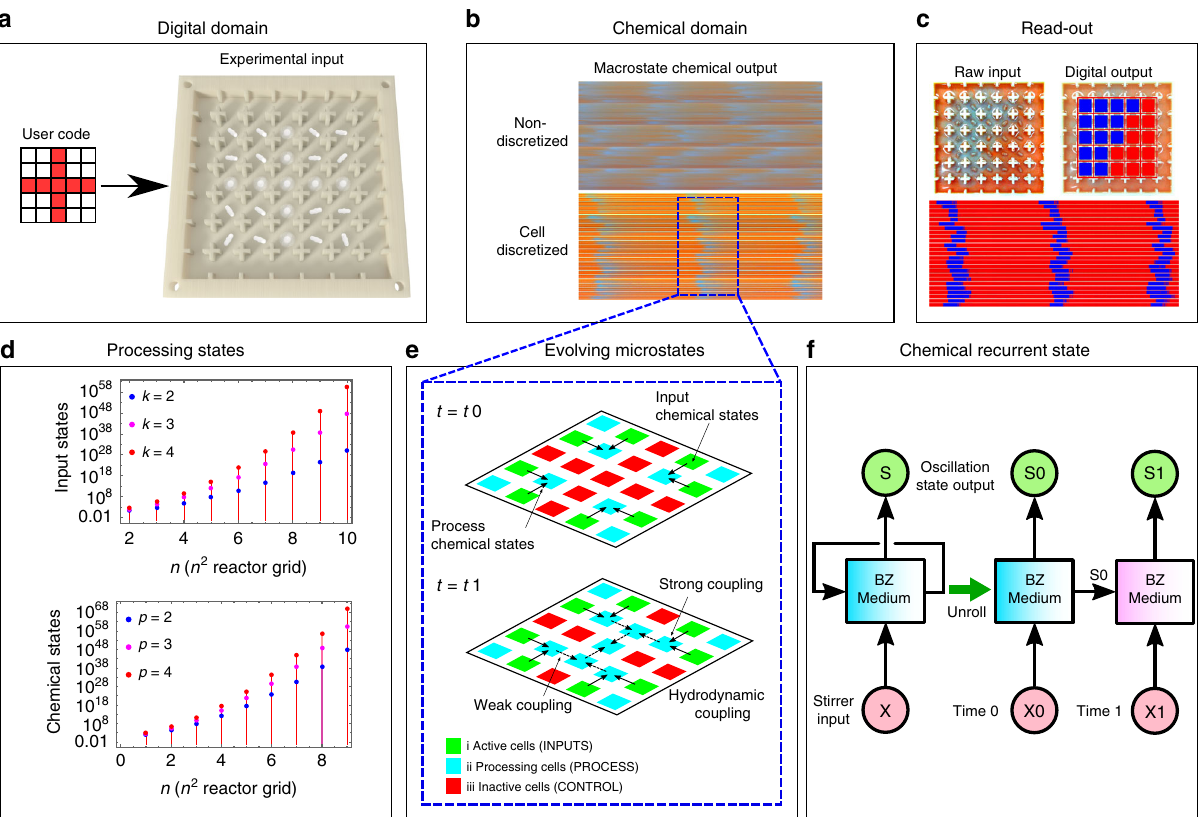
Fig. 1 Chemical processor paradigm. a Digital domain: The user inputs the actions to perform via a 5-by-5 matrix. This digital matrix is read by a computer and translated into machine code to mechanically actuate the stirrers at the user-de fi ned speed. b Chemical domain: Based on the speed at which the stirrers rotate, the BZ reaction will oscillate between its two states, and oscillating waves will appear in the platform. If the arena does not contain physical boundaries between the cells, the oscillations will not localize and they would spread. If there are physical boundaries between the cells, the oscillations will localize at the speci fi c cells within the arena. c Read-out: Using a camera and image processing, the states of the chemical processor are read by a digital computer. For every cell, the image processing algorithm will classify its state as on or off, depending on if the BZ reaction is oscillating on it. This step will return a 5-by-5 digital matrix representing the state of the system at each cell. d The Input States plot shows the scaling of the number of input states with the number of BZ cells on the experimental platform at different PWM stirring inputs ( k nxn , where k can be 2, 3 and 4). The Chemical States plot shows scaling of the number of chemical states (de fi ned by the distinct measurable amplitudes of BZ oscillations; see Supplementary Information) with the number of BZ cells on the experimental platform at a different number of measurable oscillation amplitudes (( p + 1) nxn where p describes the different detectable oscillation amplitudes and an additional one for no oscillation). e Evolving microstates: The cells in the arena are weakly connected; therefore, their oscillations will convolve, and be able to perform complex calculations by controlling the stirring speeds into (i) active cells — fast stirring — for inputs, (ii) process cells — slow stirring, (iii) inactive cells — no stirring (see Supplementary Information). f Chemical recurrent state: Because the BZ oscillations have memory, the global state of the medium not only depends on the input, but also on the state of previous